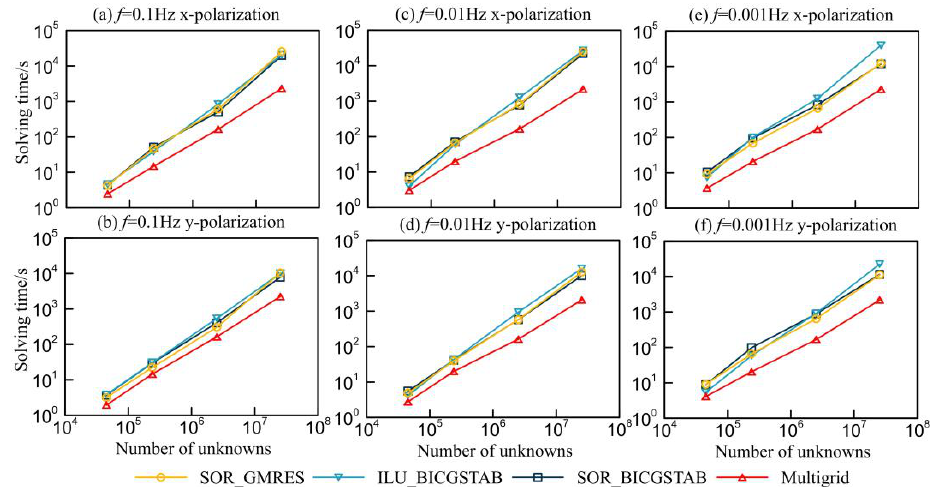
Figure 9 . Comparison of computational time for SOR-GMRES, ILU-BICGSTAB, SOR-BICGSTAB, and MG algorithm for COMMEMI3D-2 model in x - and y -polarization modes at 0.1, 0.01, and 0.001 Hz. The residual threshold is 10 −7 . The computation is conducted respectively on the grids of 24 × 24 × 24, 48 × 48 × 33, 128 × 128 × 50, 256 × 256 × 128, with the number of unknowns being 45,000, 239,169, 2,516,274, 25,428,608, respectively.